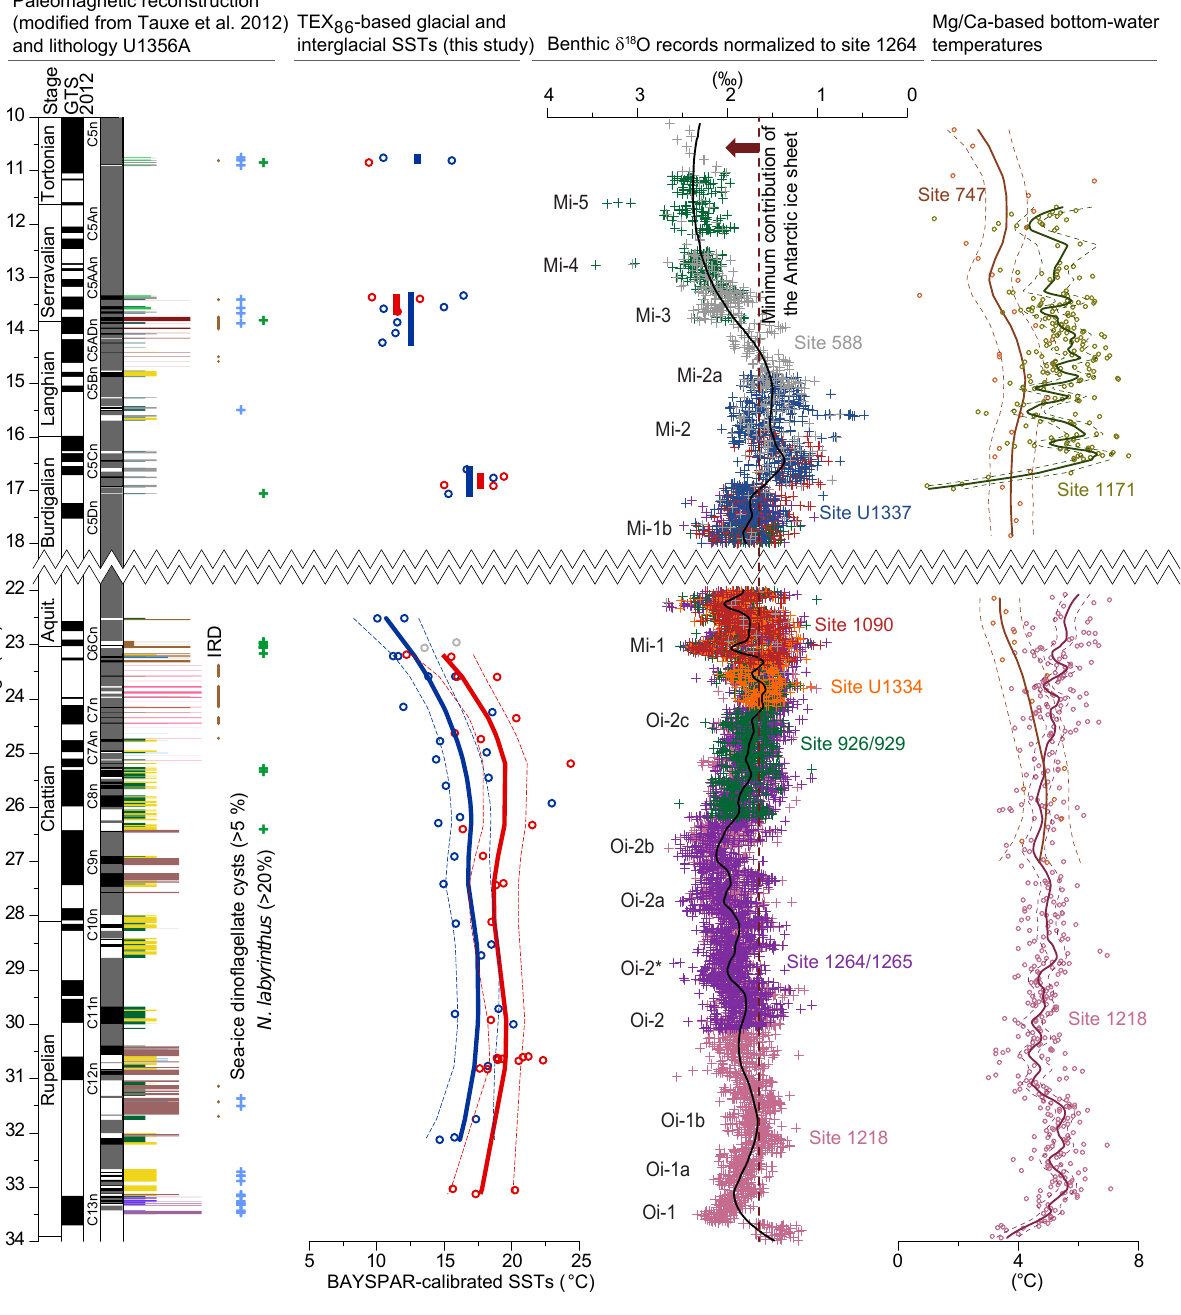
Figure 4. Lithology and paleomagnetic polarities as in Fig. 2, but plotted against age (Ma), updated to the GTS2012 timescale (Gradstein et al., 2012). Sections with IRD and samples with sea ice and Nematosphaeropsis labyrinthus dinoflagellate cysts are indicated. SST values are based on the BAYSPAR calibration with blue and red open circles indicating glacial and interglacial temperature estimates, respectively, based on the lithology (see text). For the Oligocene, thick blue and red lines are the LOESS average glacial and interglacial trends with their 95% confidence interval (dotted lines). For the Miocene, thick blue and red straight lines indicate glacial and interglacial means for the corresponding data clusters. Benthic δ 18 O records are normalized to the δ 18 O record of Site 1264 (in purple). Colored + signs indicate the different DSDP/ODP/IODP sites (refs. in text) and the black line is the LOESS average. Oi and Mi glaciation events are indicated. The area below the benthic δ 18 O record on the left side of the dark red dotted line (1.65‰) indicates the minimum contribution (‰) of the Antarctic Ice Sheet to the benthic δ 18O record, assuming BWT at Site 1264 did not drop below its modern-day value (see Liebrand et al., 2017). Mg / Ca-based BWT records of three ODP/IODP sites with LOESS averages (solid lines) and 95% confidence intervals (dotted lines) on the far right (refs. in